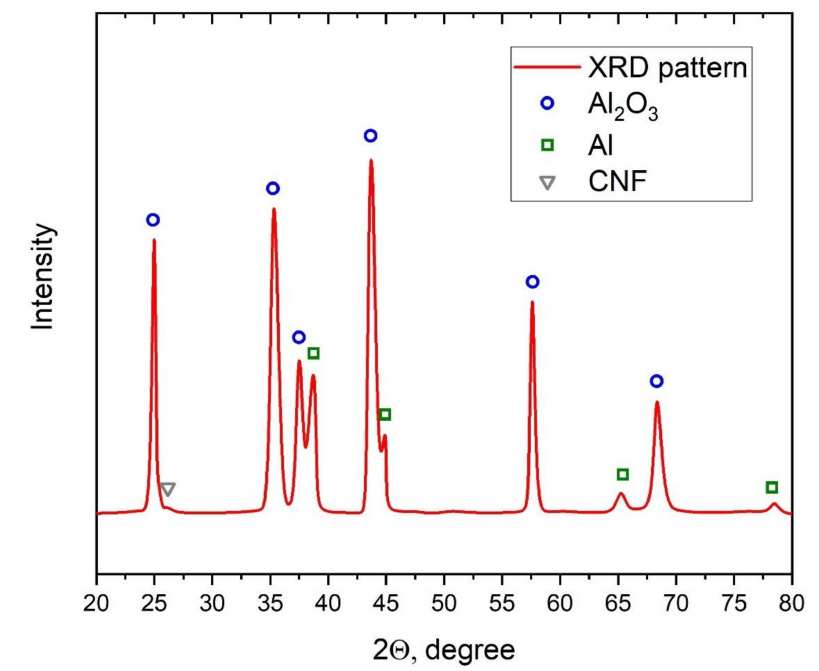
Figure 10. XRD of the 28.5% Al + 70% Al 2 O 3 + 1.5% CNF